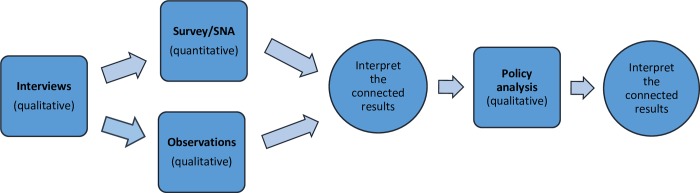
Mixed methods research design [33].